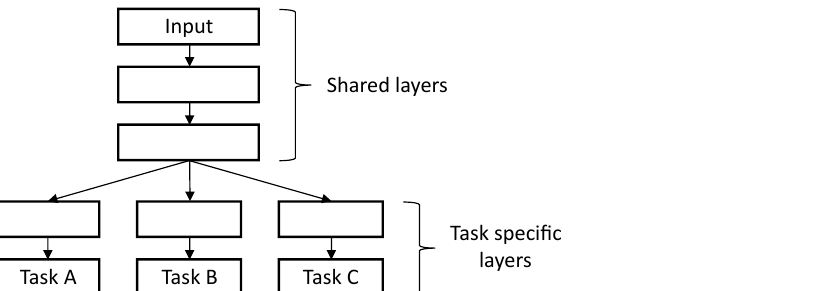
Figure 3. Deep neural network implementation of a hard parameter sharing for the multi-task learning.